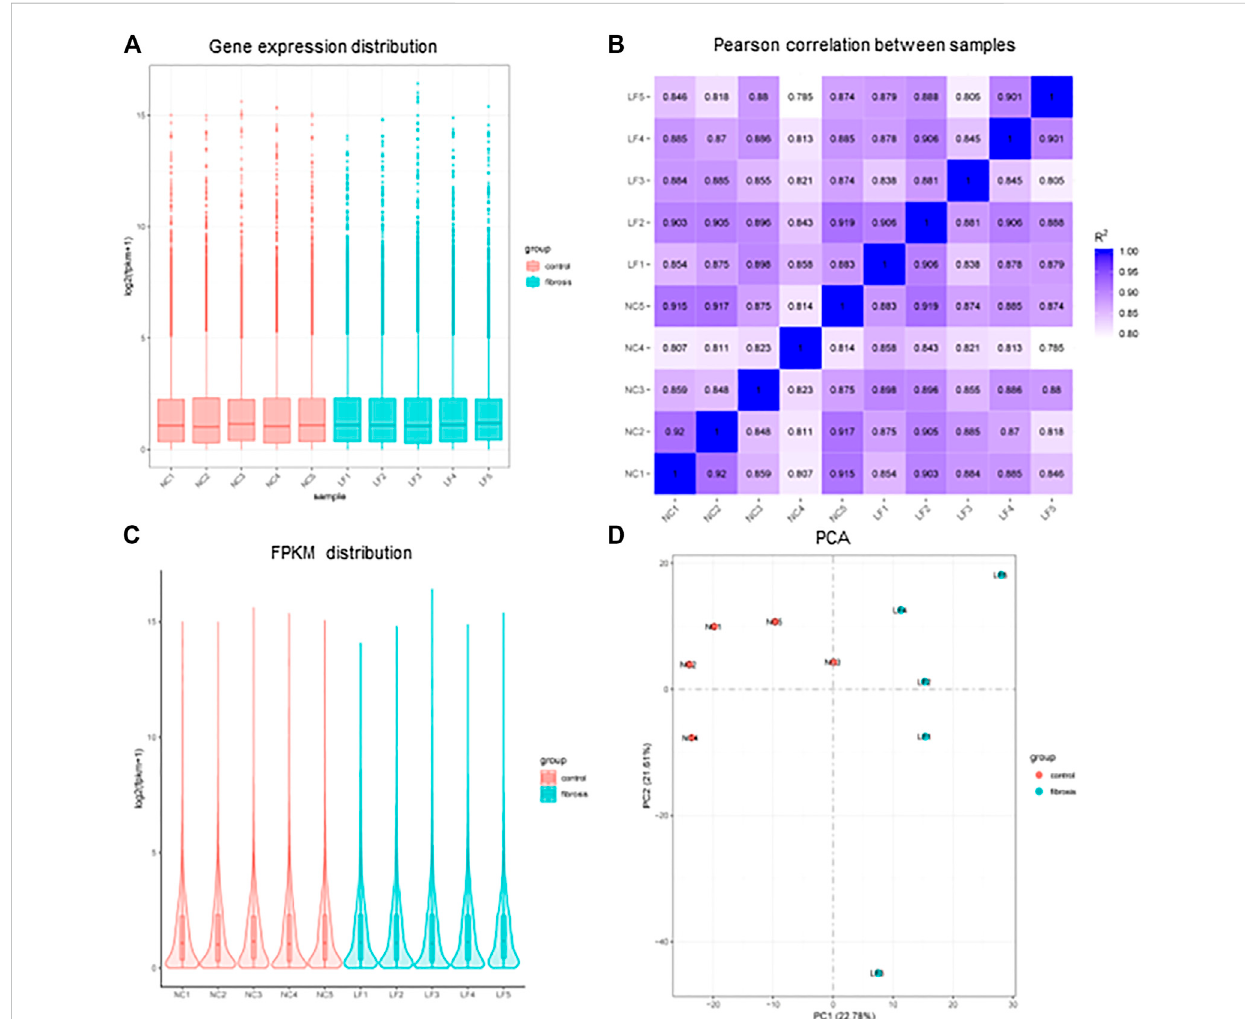
FIGURE 1 Distribution of sample expression situation after normalization. (A) Gene expression distribution of each sample. (B) Plot of Pearson correlation coef fi cient between samples. (C) Fragments Per Kilobase of exon model per Million mapped fragments (FPKM) distribution of each sample. (D) Principal Component Analysis (PCA) diagram. n = 5, LF, liver fi brosis; NC, normal